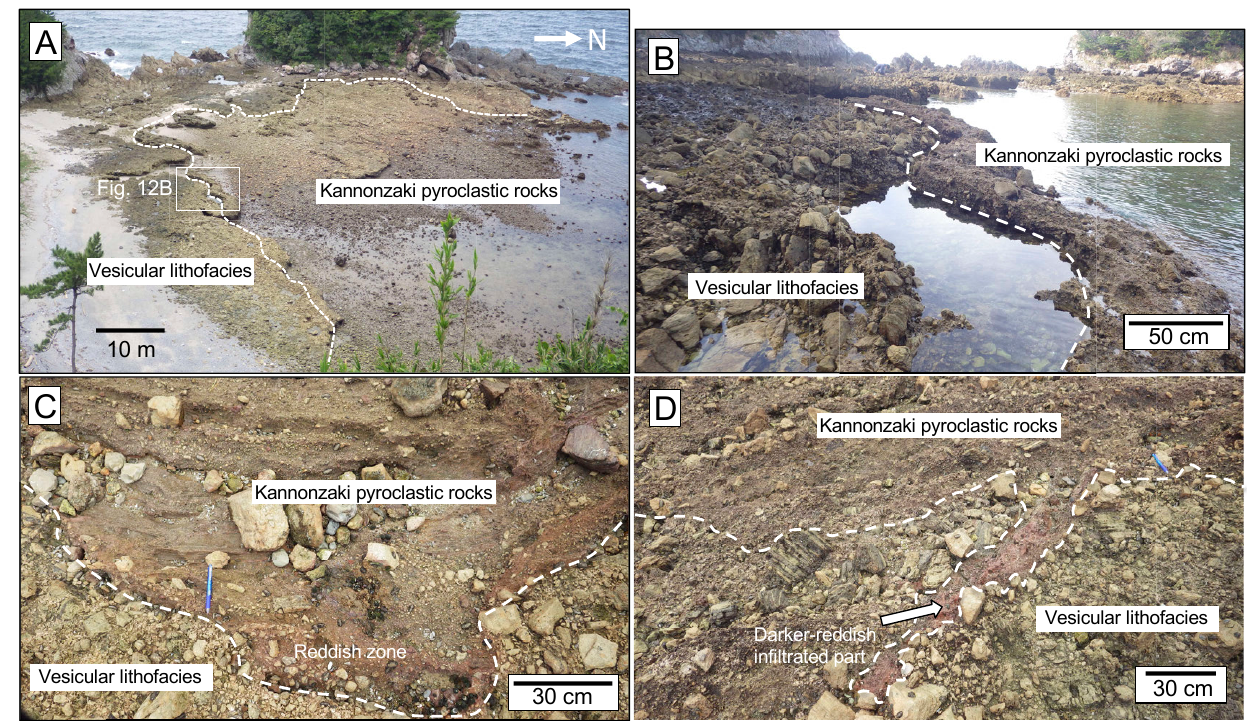
Figure 12: [A] Photograph (view to the west) indicating boundary (dotted line) of the vesicular lithofacies of Shi- royama lava and the Kannonzaki pyroclastic rocks. [B] Close-up view of the contact (dotted line) of them. The Kannonzaki pyroclastic rocks are deformed along the lava margin. [C] The Kannonzaki pyroclastic rocks along the lava margin (dotted line) show reddish color, indicating oxidized. [D] The infiltrated part (arrow) of the Kannonzaki pyroclastic rocks show darker reddish